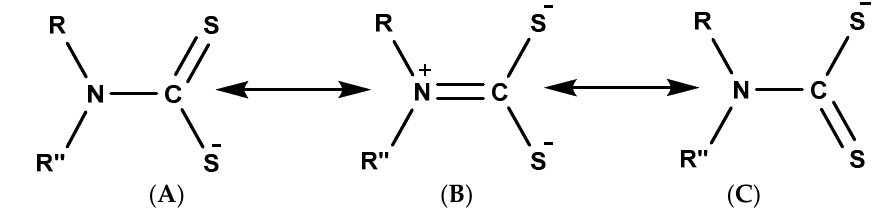
Figure 1. Resonance structure of dithiocarbamate.